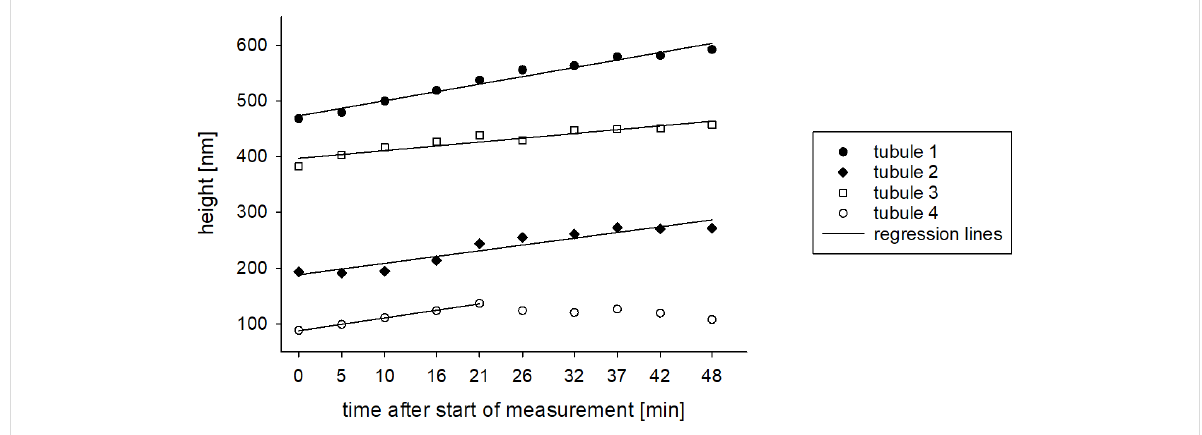
Figure 7: Diagram of height increase of vertically growing tubules from a wax solution on glass. Time zero represents height measurements 22 h and 29 min after the application of the wax solution. The curves were fitted by linear regression lines (f = y 0 + a·x). R² ≥ 0.9.